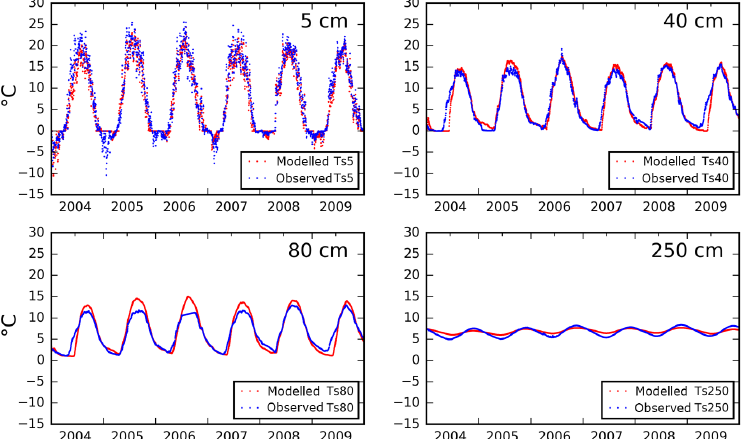
Figure 7. Simulated and observed daily mean soil temperature T s ( ◦ C) at 5, 40, 80, and 250cm at the Mer Bleue bog. Note that the simulated temperatures at 40 and 80cm are interpolated from the simulated soil layer temperatures above and below these depths. The deepest measurement corresponds approximately to the midpoint of the lowest soil